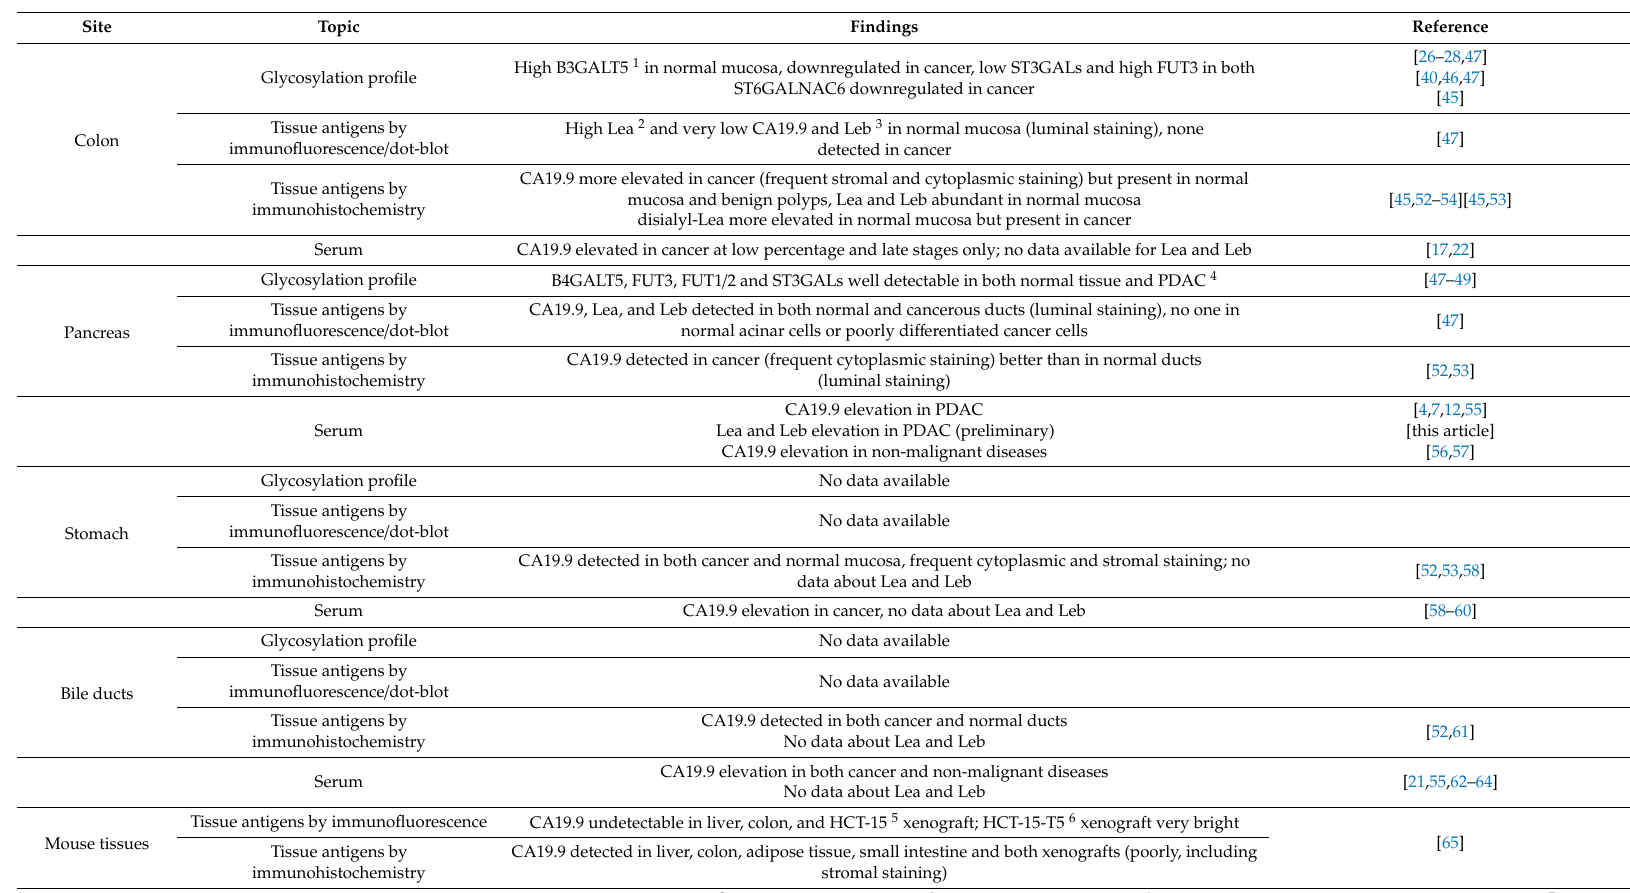
Table 1. Features of type 1 chain Lewis antigens in gastrointestinal